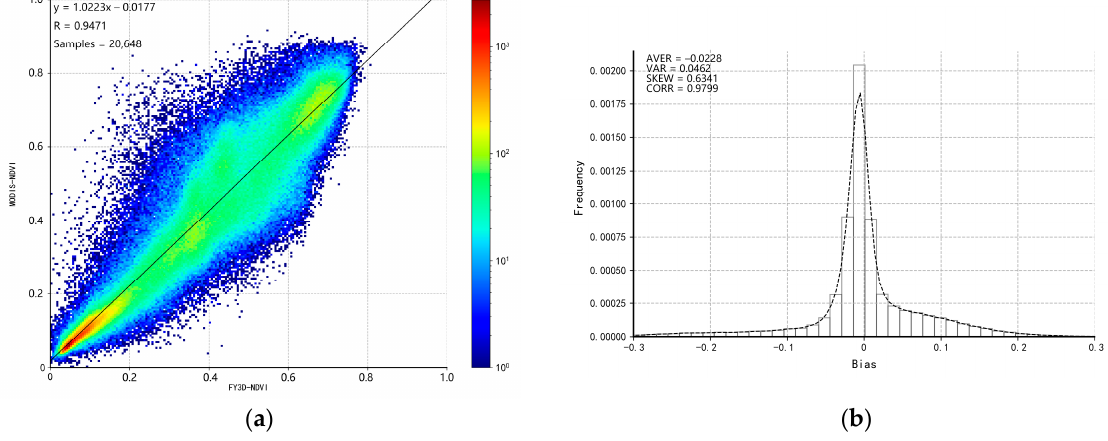
Figure 4. Density scatter plots of FNDVI versus MNDVI ( a ) and the histogram of the annualized standard deviation between MODIS and FY3D MERSI-II NDVI ( b ) during 2020 and